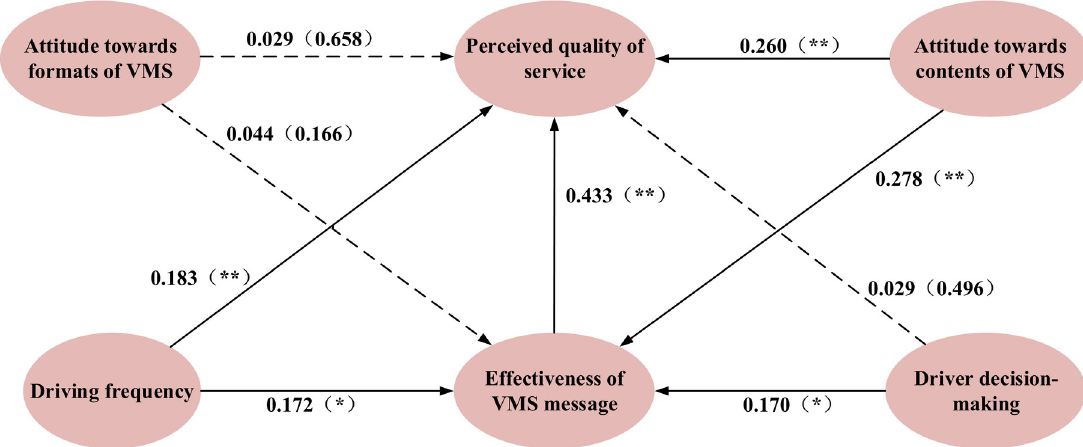
Fig 7. Estimated results of MIMIC model for taxi drivers (Model III). Notes: �� Coefficients are statistically significant at the 5% level ( � p < 0.05, �� p < 0.01).